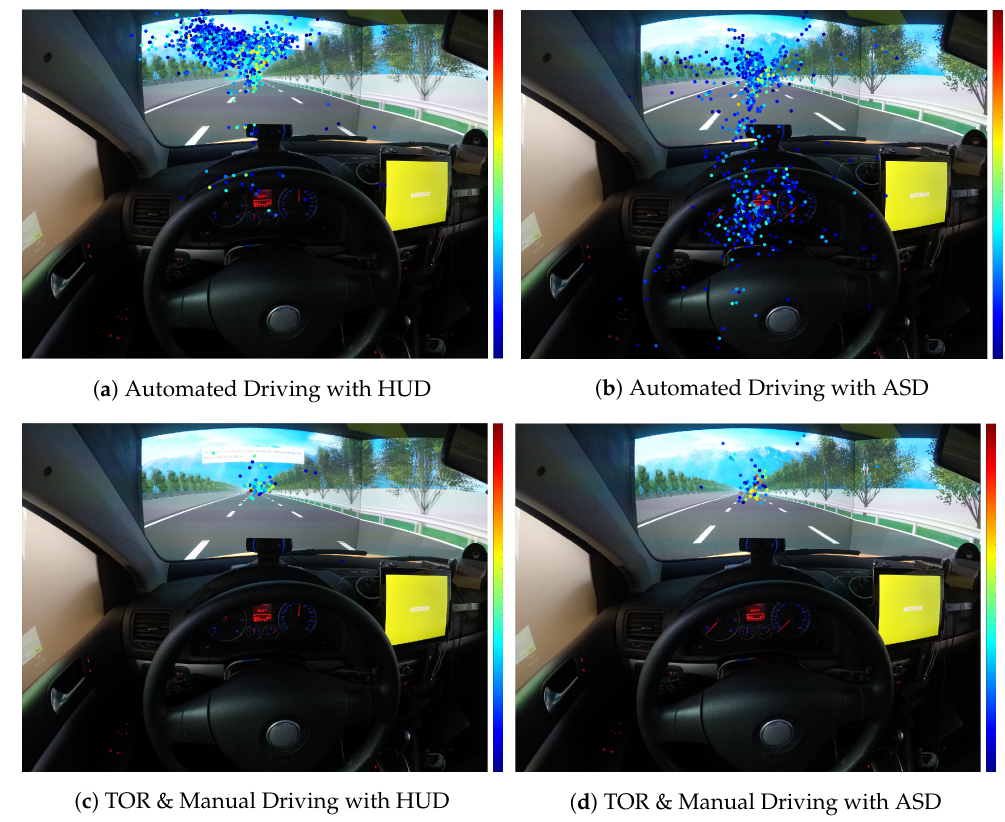
Figure 4. A participant’s fixations during automated driving ( a , b ) and during take-over phases with manual driving and handback to to automated driving ( c , d ) per condition (HUD: a , c ; ASD: b , d ). The color scale indicates fixation duration with logarithmic scaling from the minimum (blue) to the maximum fixation duration